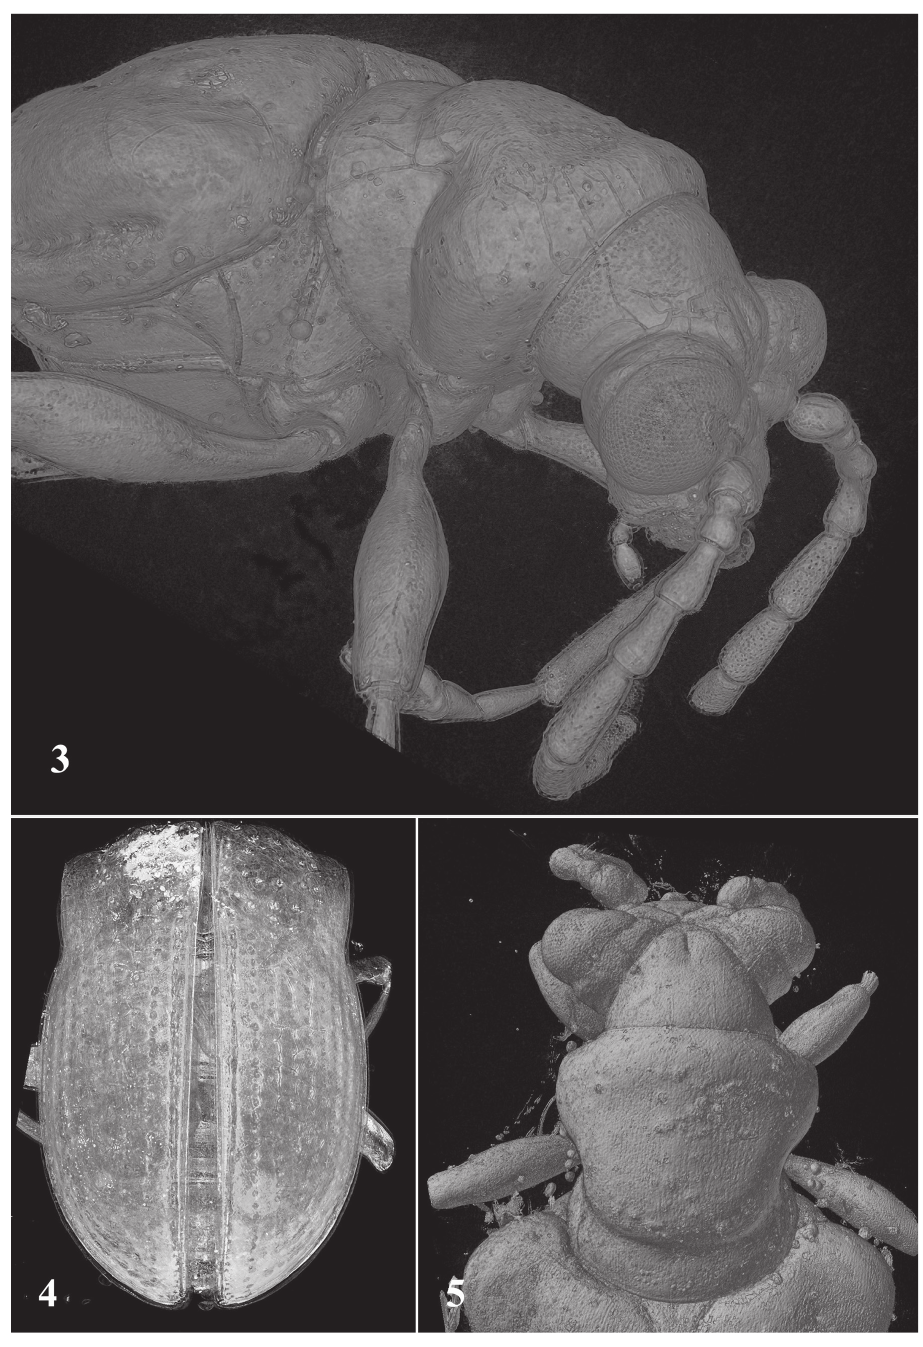
Figures 3–5. Lilioceris groehni sp. n., holotype, microCT images: 3 habitus, fronto-lateral view, showing the pronounced arcuate constriction behind the disk of the pronotum 4 elytra, dorsal view 5 details